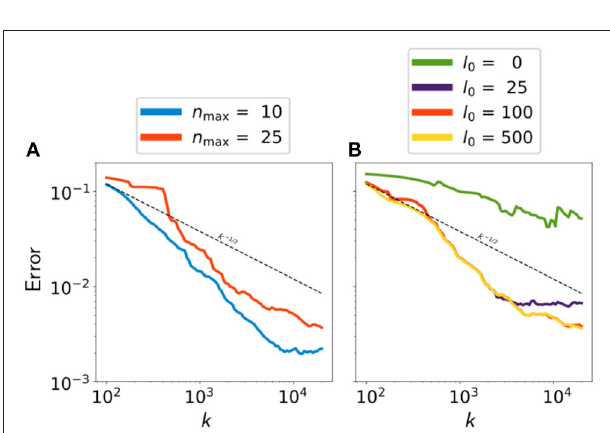
FIGURE 8 | Error between ˆ µ k and µ ex for a fixed l 0 = 100 and variable n max (A) , and fixed n max = 25 and variable l 0 (B) .